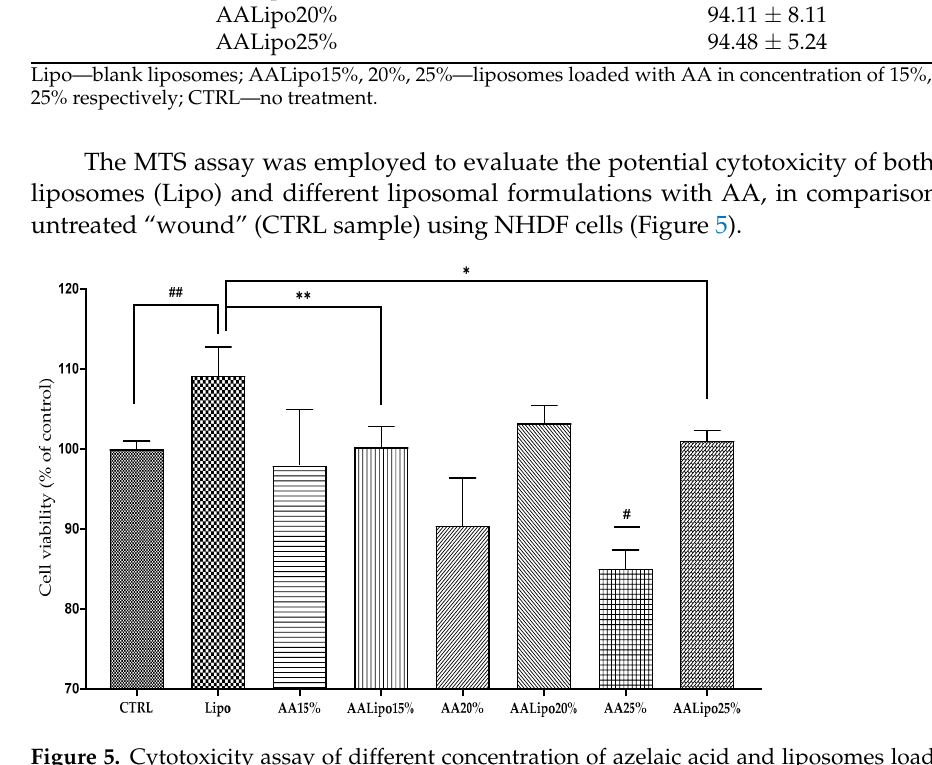
Figure 5. Cytotoxicity assay of different concentration of azelaic acid and liposomes loaded with azelaic acid (AALipo15%, AALipo20%, AALipo25%) compared to the untreated sample (CTRL) and the positive control (Lipo) with respect to human dermal fibroblasts. All values were expressed as mean ± SD. Samples (Lipo, AA15%, AA20%, and AA25%) were compared with CTRL ( # p < 0.01, ## p < 0.05), and liposomes loaded with different doses of azelaic acid were compared with Lipo sample (* p < 0.01, ** p <